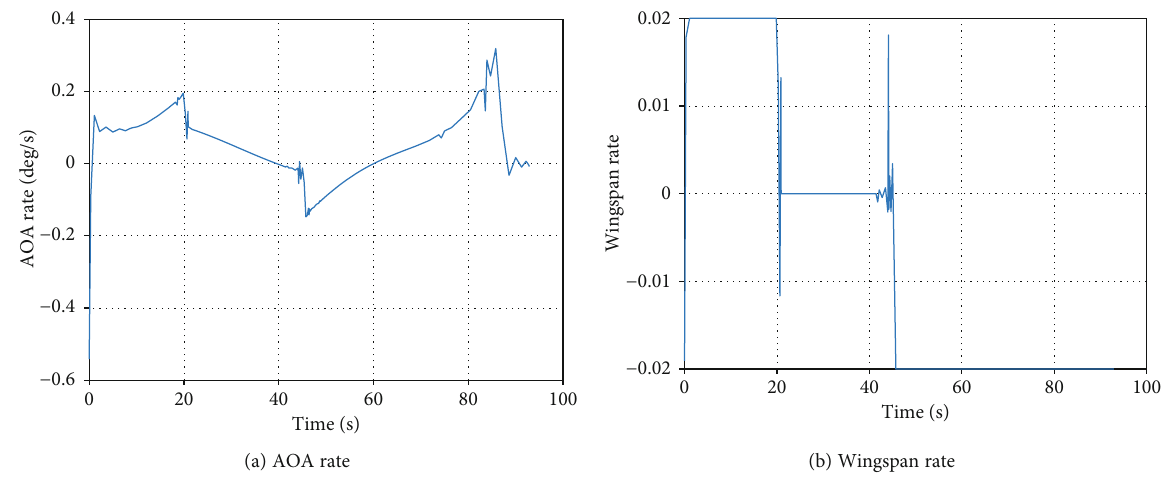
Figure 4: The time history of the attack angle rate and wingspan